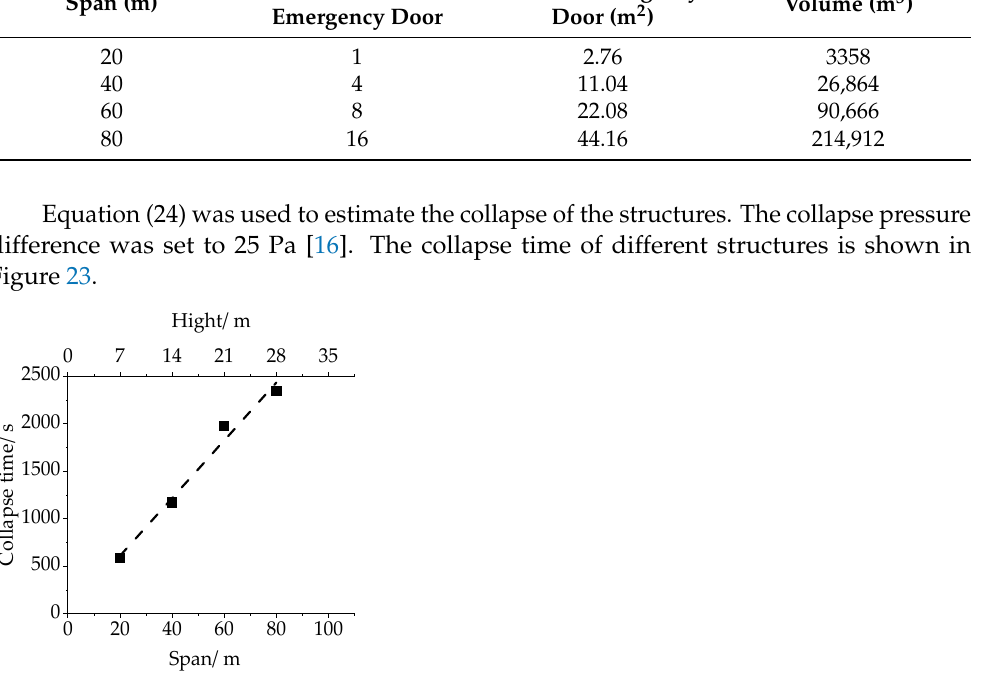
Figure 23. Collapse of different structures.